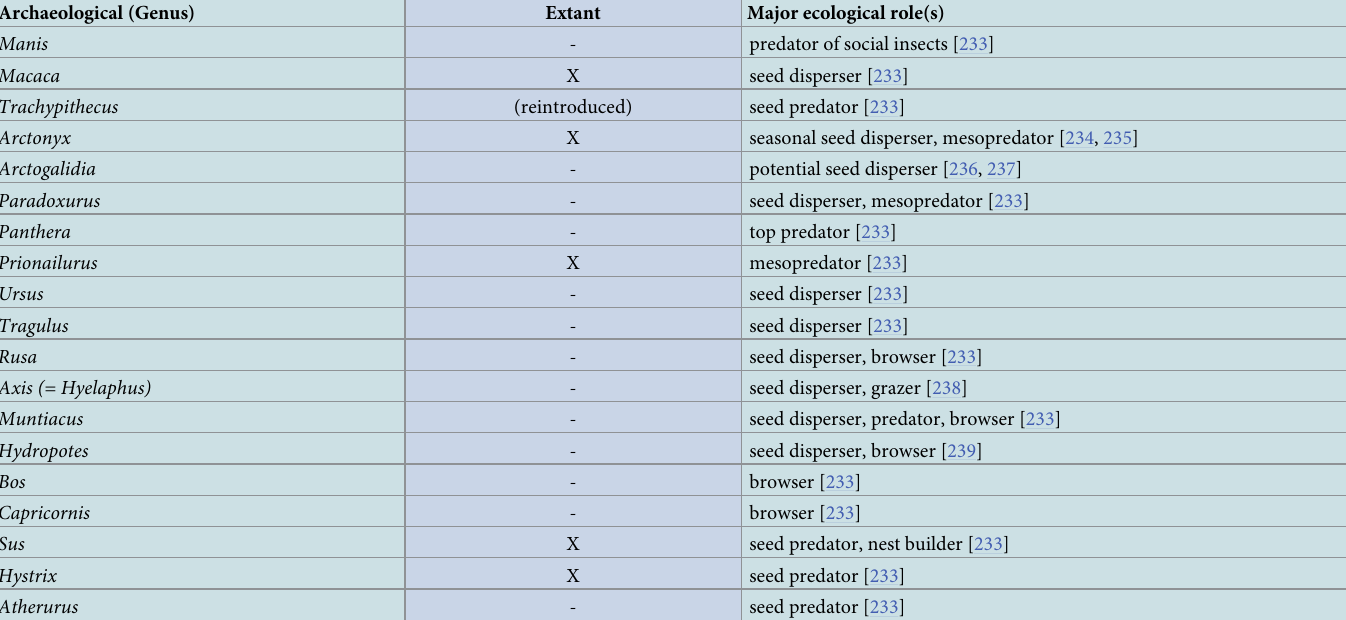
Table 1. Mammalian genera ( � 2 kg) identified from archaeological investigations in Tr à ng An by the SUNDASIA project compared to those recorded in the same landscape today and their major ecological role(s) with associated